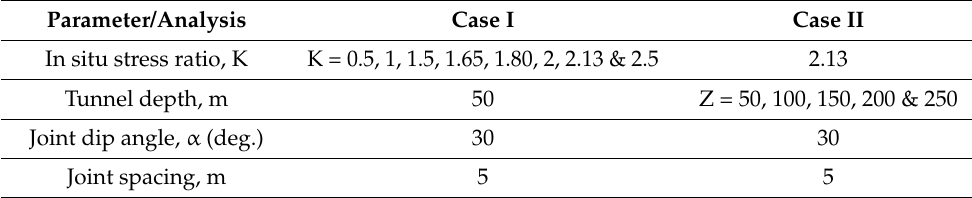
Table 1. Different factors considered during the sensitivity analysis.